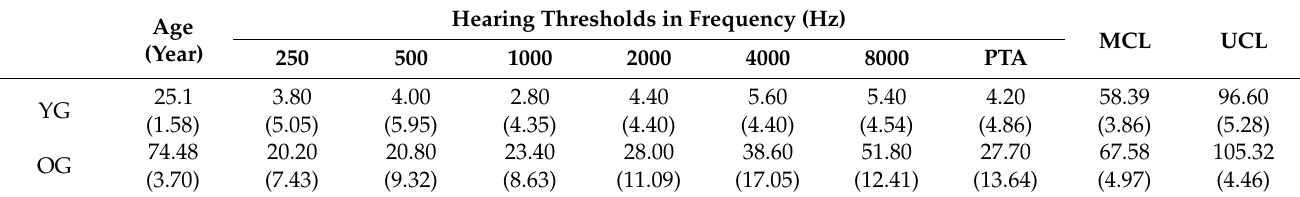
Table 1. Hearing information between young and older adults as group mean and standard